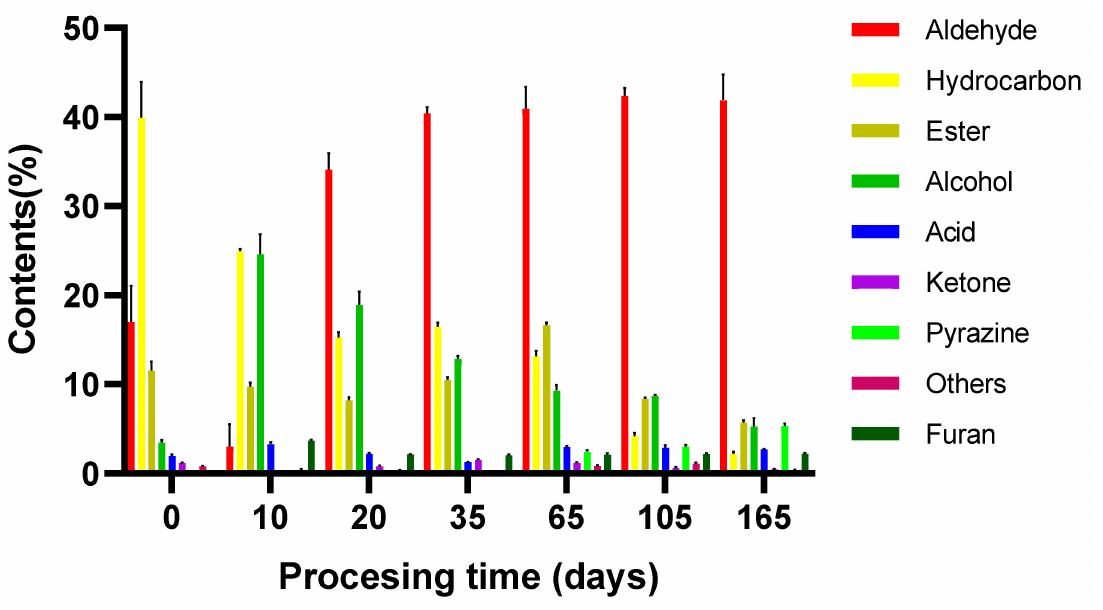
Figure 1. The relative contents of different flavor compounds detected in samples during the process- ing of dry-cured donkey leg. Processing times: 0 days: green leg; 10 days: start of salting; 20 days: middle of salting; 35 days: end of salting; 65 days: start of fermentation; 105 days: end of fermentation; 165 days: aging. The black bars of different lengths indicate significant differences between each group. ( p <